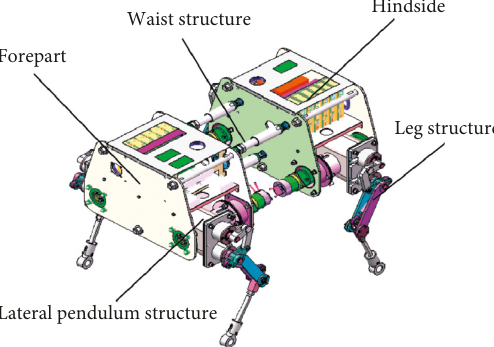
Figure 1: The 3D model of the MQ quadruped